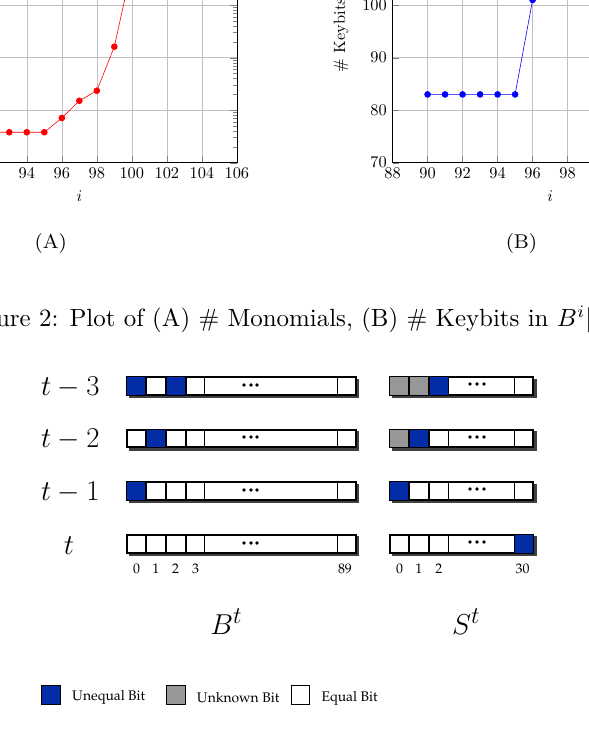
Figure 3: Backward Differential characteristic for 3 rounds in Phase